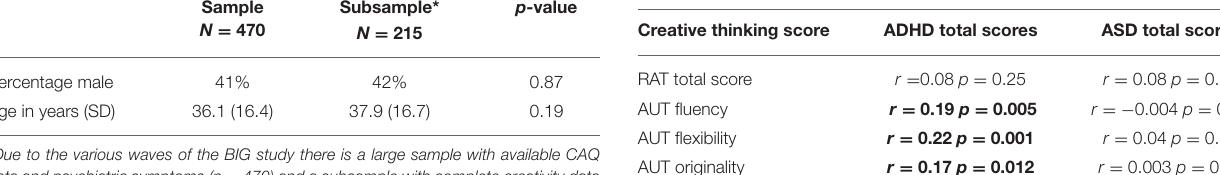
TABLE 3 | Correlations of ADHD & ASD total scores with convergent and divergent thinking scores in the BIG study (population-based